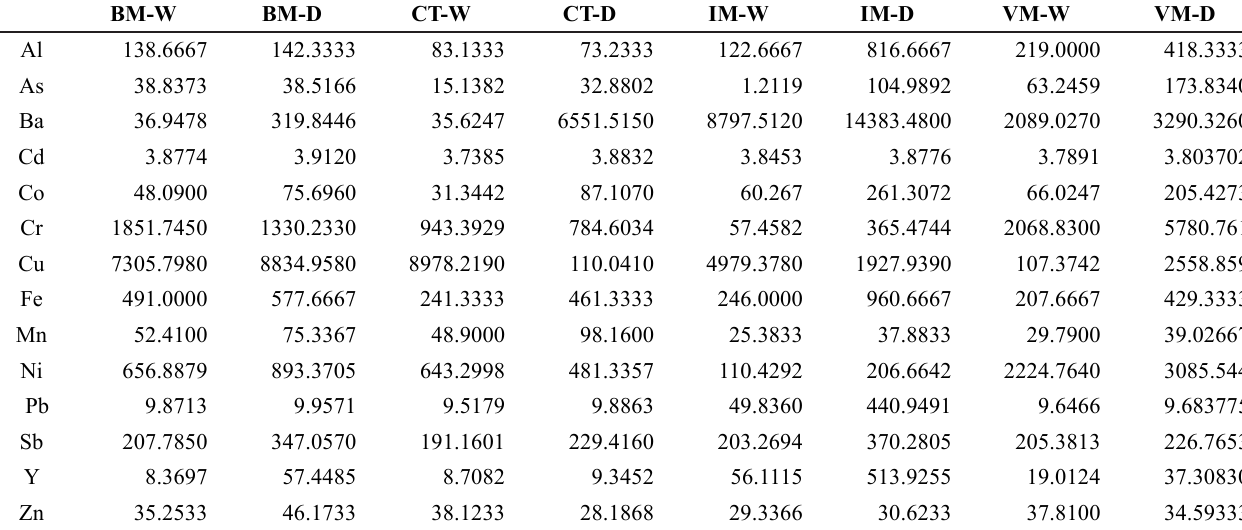
Table 5 . Mineral contents in µg/Kg and mg/Kg for 54 dehydrated bee pollen samples collected during wet (W) and dry (D) season, from four sites in the Iron Quadrangle, MG, Brazil. (*) average of concentration no samples with <LOQ. Samples read in ICP-OES: mg/Kg (Al, Fe, Mn and Zn). Samples read in ICP-MS: µg/Kg (As, Ba, Cd, Co, Cr, Cs, Cu, Ni, Pb, Sb and Y). Codes for areas are as in Figure 1.